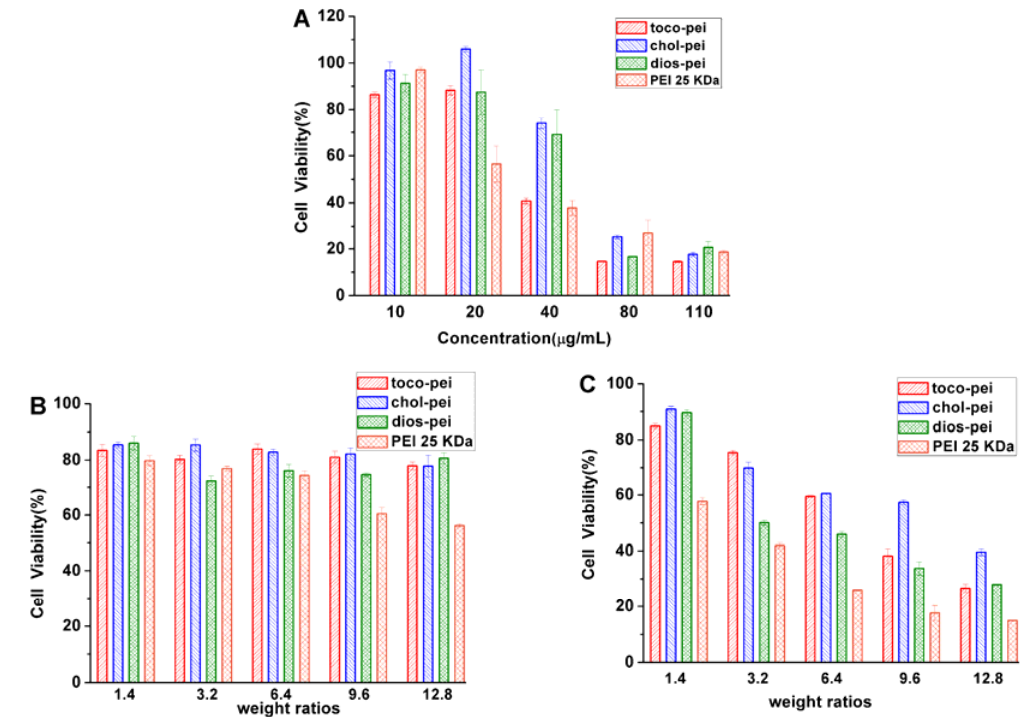
Figure 7. Cell viabilities of lipopolymers at all kinds of concentrations toward HeLa cells ( A ), and lipopolymers/plasmid enhanced GFP (pEGFP) polyplexes at different w / w ratios toward MCF-7 ( B ) and HEK293 cells ( C ); 25-kDa PEI was used as the control (mean ± SD, n = 3).